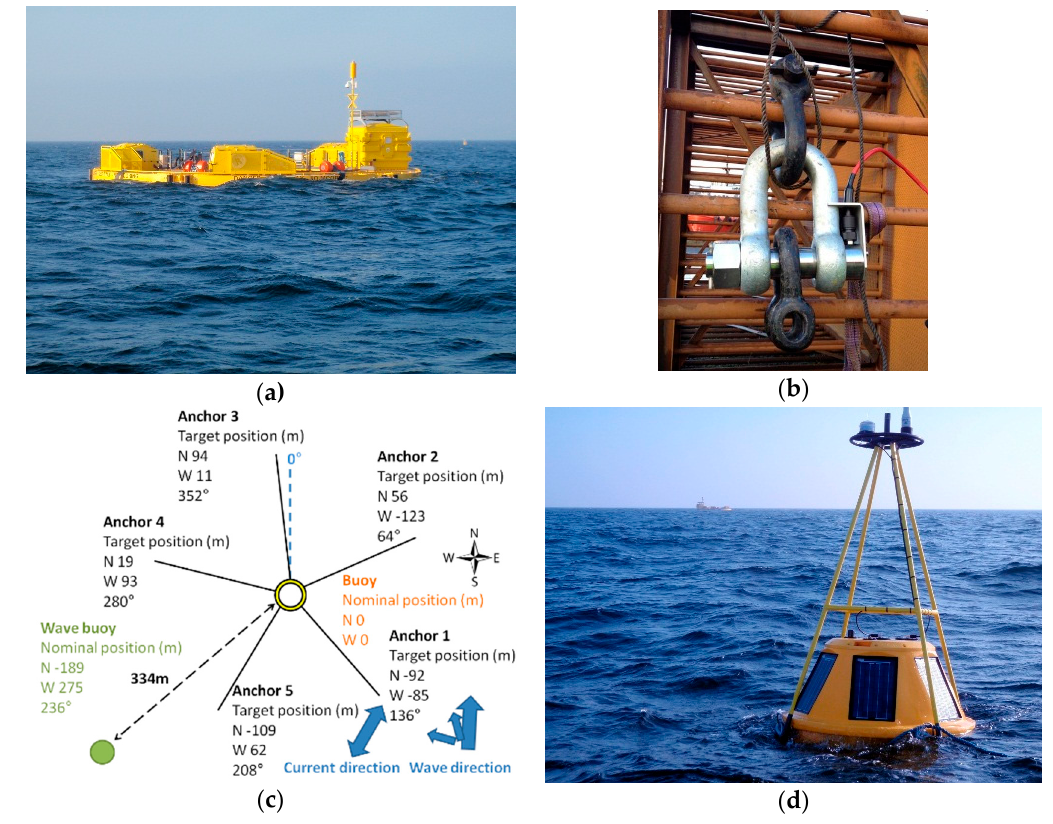
Figure 3. Bolt ‐ 2 Lifesaver arrangement and instrumentation: ( a ) floating structure; ( b ) mooring load cell; ( c ) plan view layout of the mooring system and wave buoy; and ( d ) adjacent wave buoy. Table 4. Summary of the mooring line components at the Bolt ‐ 2 LifeSaver installation.